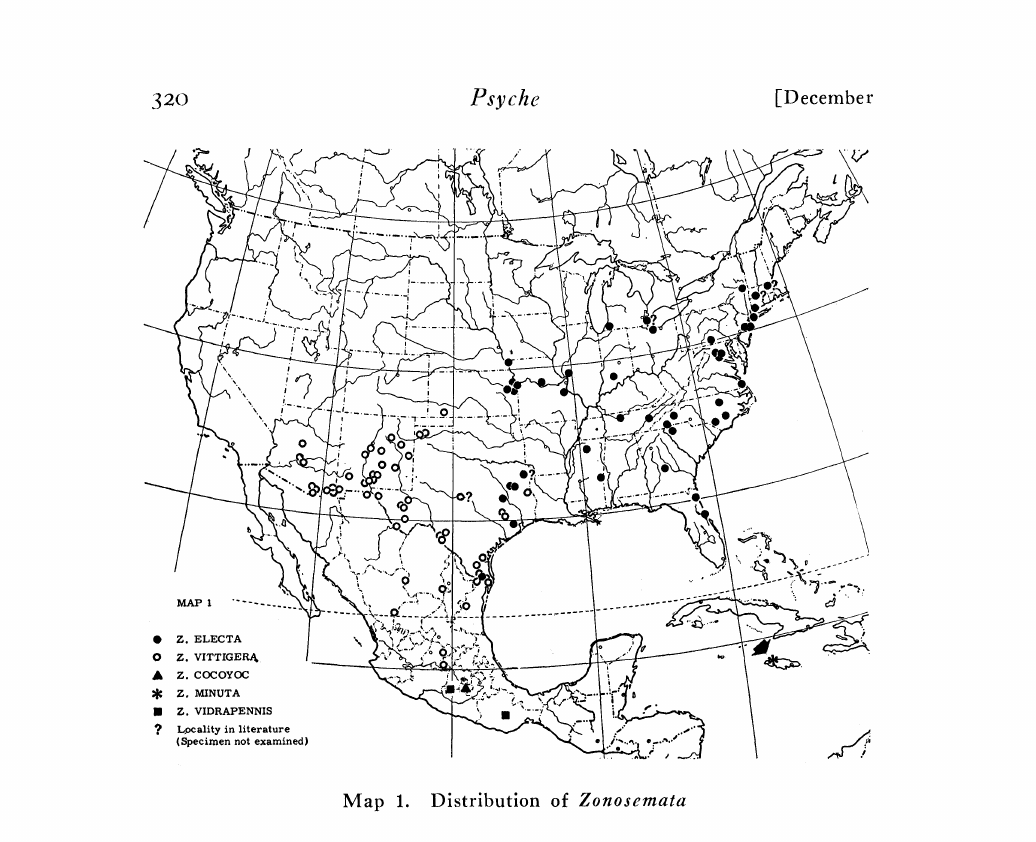
Map 1. Distribution of Zonosemata dark border around the humeral callus, and the presence, of black spotting on the last three segments of the. abdomen in both male and . female Figs. 5- 6). c. Body and ving Head: measurements in Table DSCRIP:ION indistinguishable in shape from that of electa (Fig. 3o); all regions including mentum and palps golden yellow except black ocellar triangle; po.st ocellars yellow or black; gular undifferentiated, genal and all other bristles black. Thorax (Figs. 3, 33) notopleural and sternopleural stripes and light areas of dorsum and scutellum yellow; dorsum and base of scutellum with broad dark brown to black U-shaped pattern; humeral callus in dorsal view emarginated with black; pleural regions with black stripe extending from. lower half of mesopleuron to base of postscutellum; dark brown to. black shading also present on lower half of sternopleuron. Postscutellum brownish-black. Dorsum and scutellum covered with short light yellow to brown decumbent setae. Legs: normal color and co,mple- ment of bristles for genus. ICing (Fig. 7): crossbands broad;